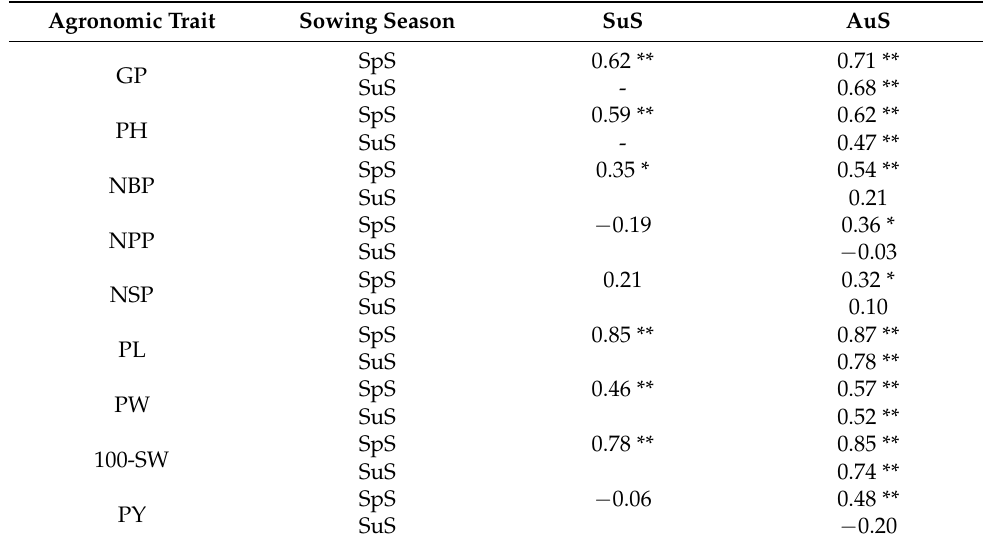
Table 4. Correlation analysis of various traits in different sowing